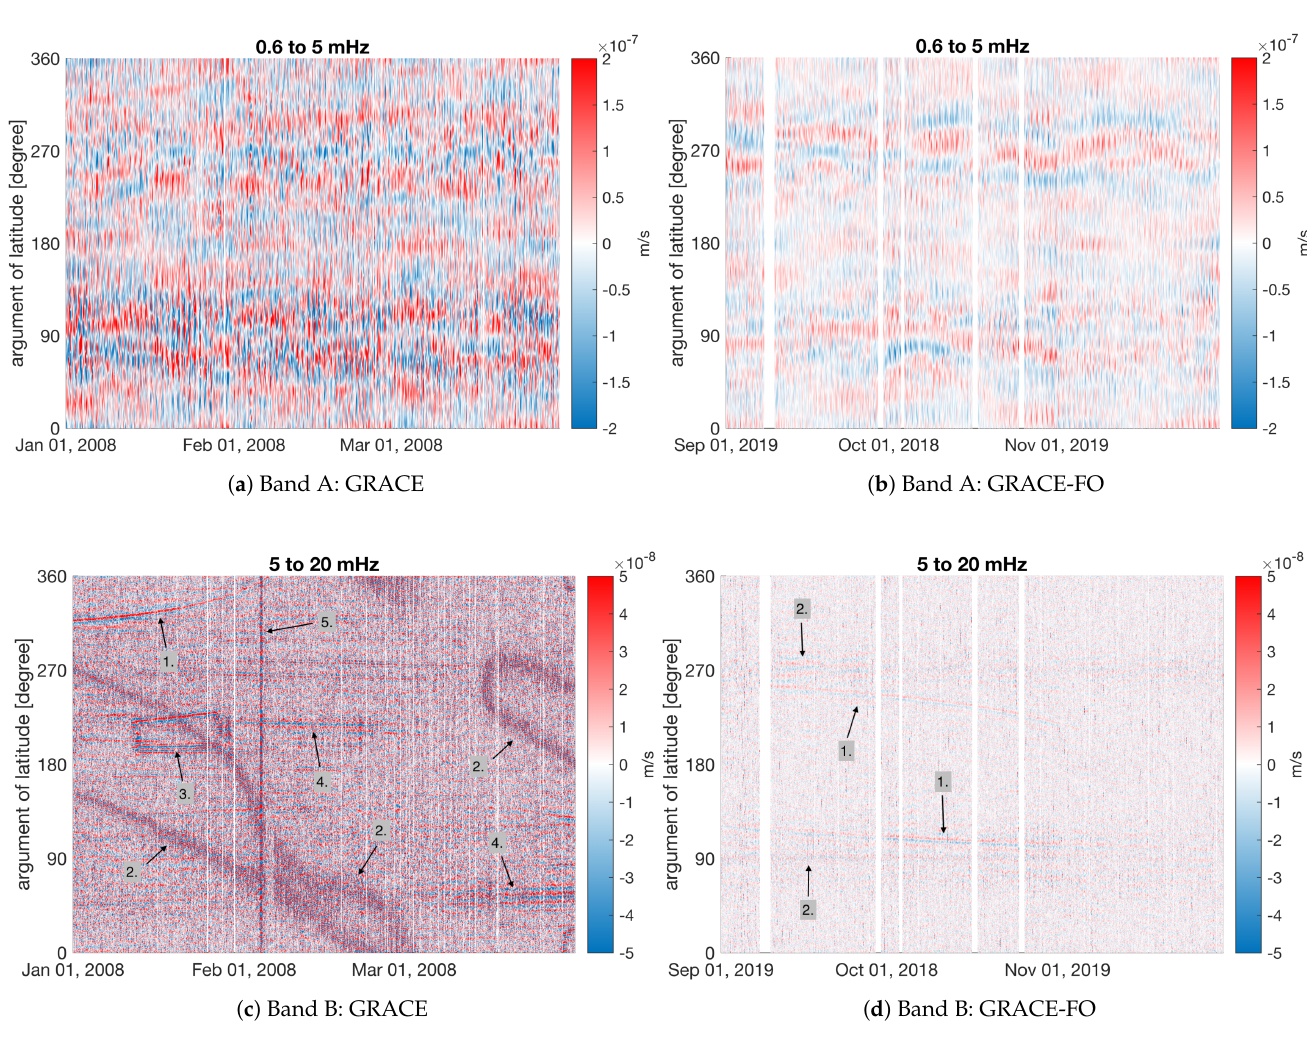
Figure 4. Time-Argument-of-Latitude (TAL) diagrams illustrating frequency filtered exemplary GRACE ( left ) and GRACE- FO ( right ) KBRR post-fit residuals. Upper panels: residuals in the 0.6 to 5 mHz frequency band; bottom panels: residuals in the 5 to 20 mHz frequency band. See text for definition of highlighted